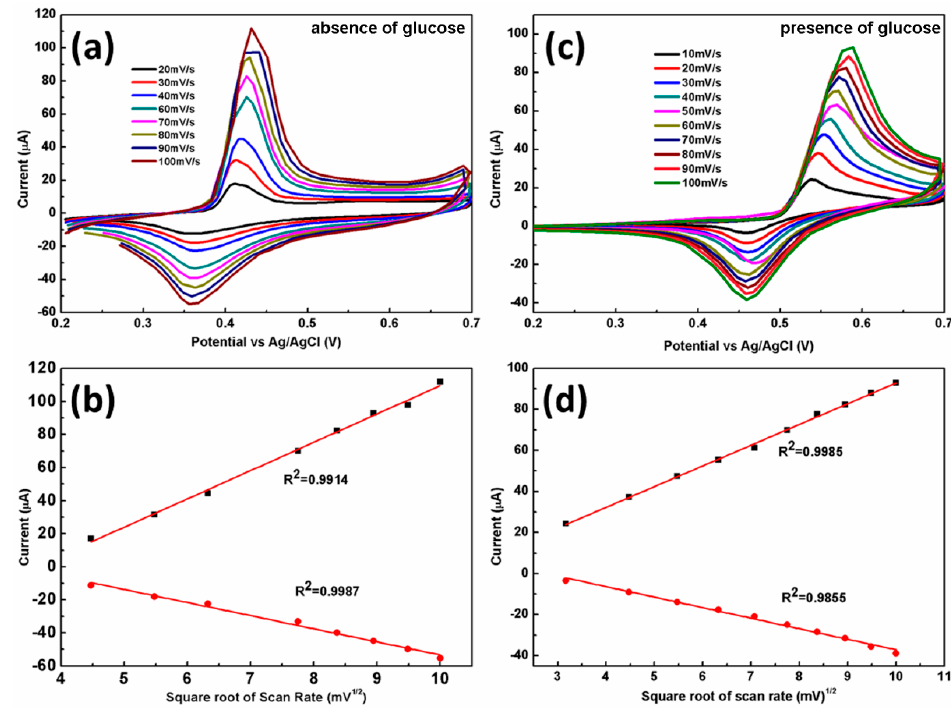
Figure 4. Cyclic voltammograms of Ni/NiO-Nafion-rGO modified SPE in absence ( a ) and presence ( c ) of glucose in 0.1 M NaOH with different scan rate; and plots of peaks current (Ip) vs. square root of scan rate in absence ( b ) and presence ( d ) of glucose in 0.1 M NaOH.